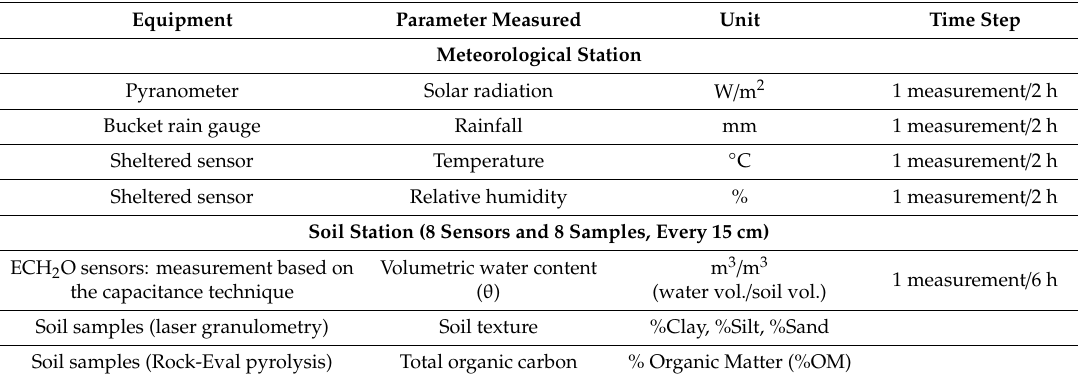
Table 2. Equipment installed at the measurement stations, parameters measured, units and time steps. Equipment Parameter Measured Unit Time Step